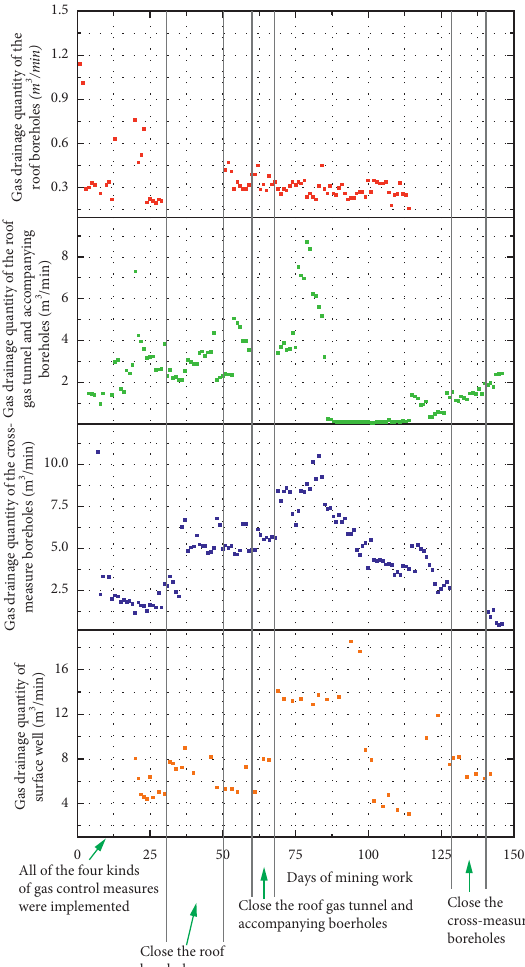
Figure 15: Variation of gas drainage quantity when using different gas drainage measures in No. 2 1024